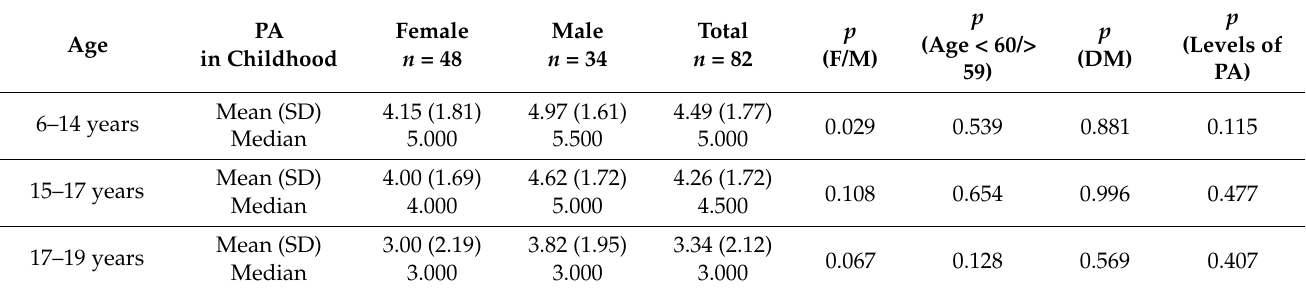
Table 3. Characteristics of the level of PA (the mean number of days in the week with a minimum of 60 min of activity per day) of the participants in childhood and adolescence and the differentiation by age, sex, the presence of DM, and the current level of PA (with the Mann–Whitney U test and the Kruskal–Wallis test for levels for PA differentiation).